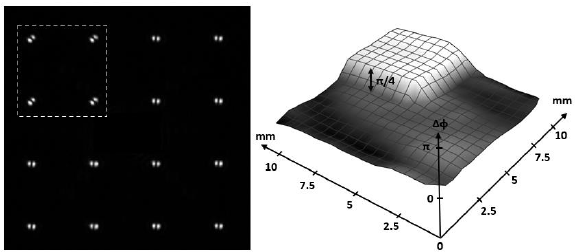
Fig. 2. Central part of the image of the SLM. The SLM is addressed with a phase map containing a phase jump in the top left corner (left figure) and reconstructed retardance jump (right figure)